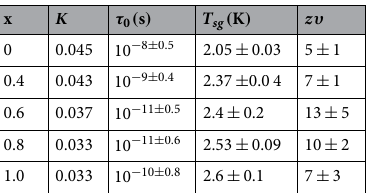
Table 4. Same parameters as those in Tables 2 and 3 using the inflection point in χ ′′ as the indicator of T f . H ac is varied as indicated in Fig. 9a.